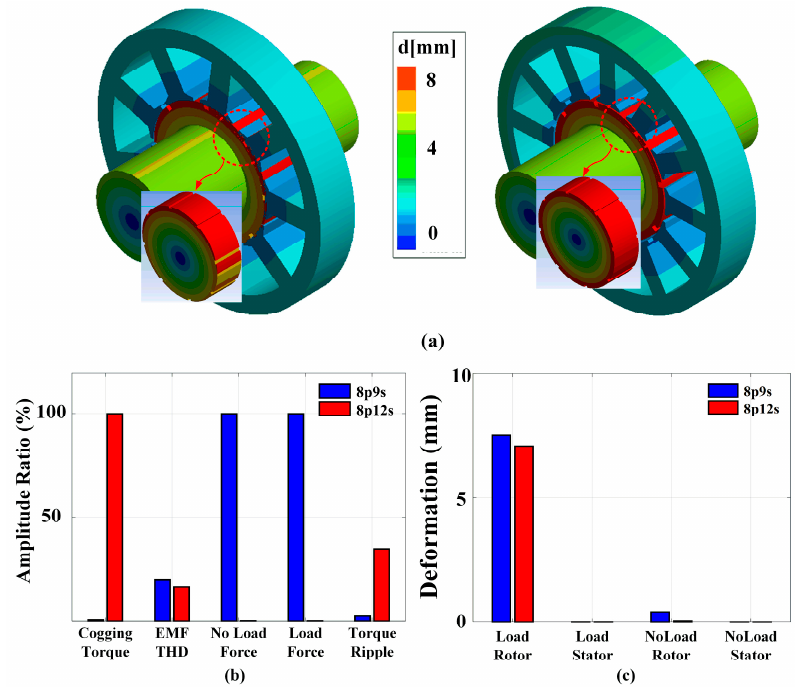
Figure 7. The analysis model of permanent magnet machines with two different pole/slot combinations: ( a ) electromagnetic analysis model and ( b ) prototype model.